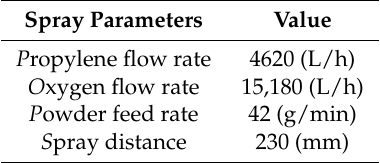
Table 2. Coating parameters of high-velocity oxygen fuel (HVOF)